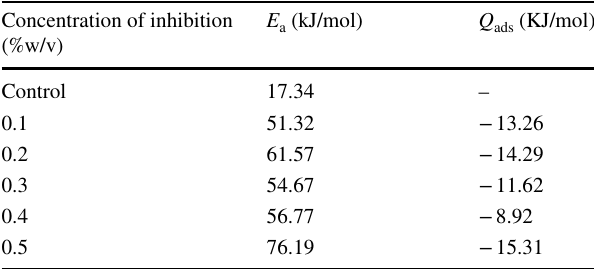
Fig. 3 Adsorption of Langmuir isotherm plot of Gongronema latifolium on the surface of mild steel at different